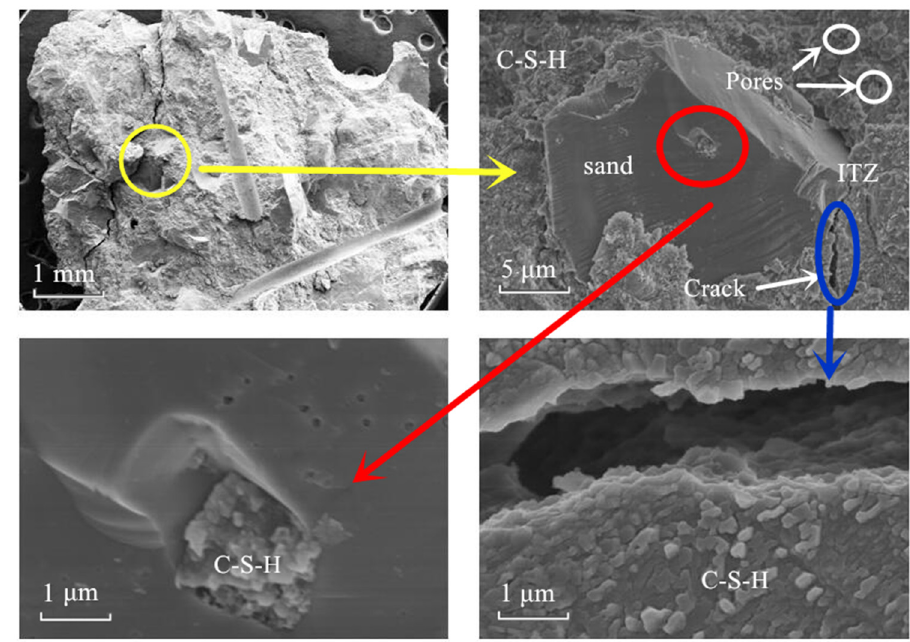
Figure 12: Microstructure of the UHPC without nanomaterials at 28